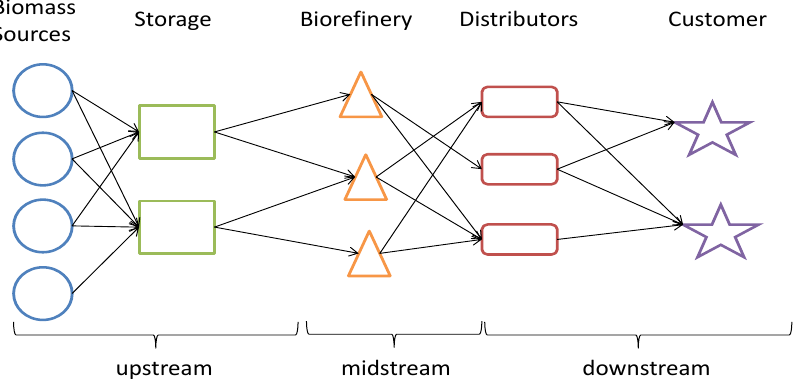
Figure 1. Schematic diagram of a generic bioenergy supply